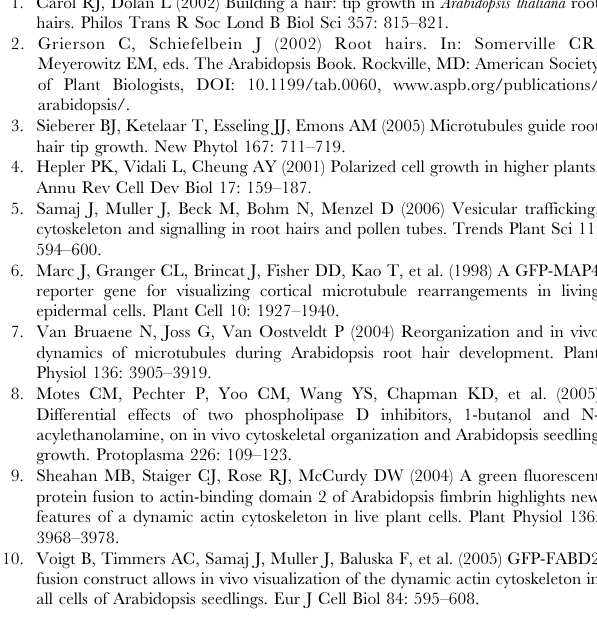
Figure S1 AF organization in wild-type (Col), mrh2-3 , CA1-1 and mrh2-3 CA1-1 root hairs. Representative GFP images for various genotypes that contain the 35S:ABD2-GFP construct were shown. Images were projections of about 50 confocal sections, separated by 1 m m distance. The bar represents 20 m m. Found at: doi:10.1371/journal.pone.0001074.s002 (2.11 MB